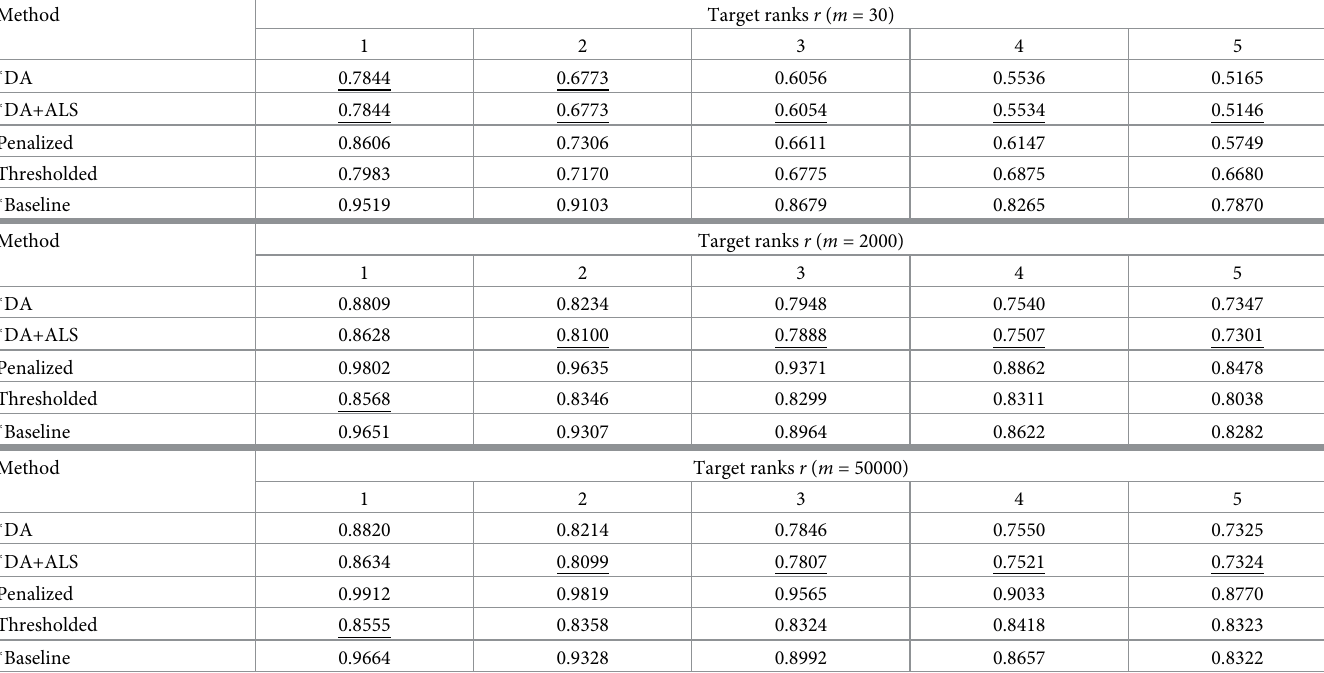
Table 3. Mean relative error for synthetic A for which a ij * Bernoulli(0.5). The � symbol indicates methods we propose. Best results are underlined.